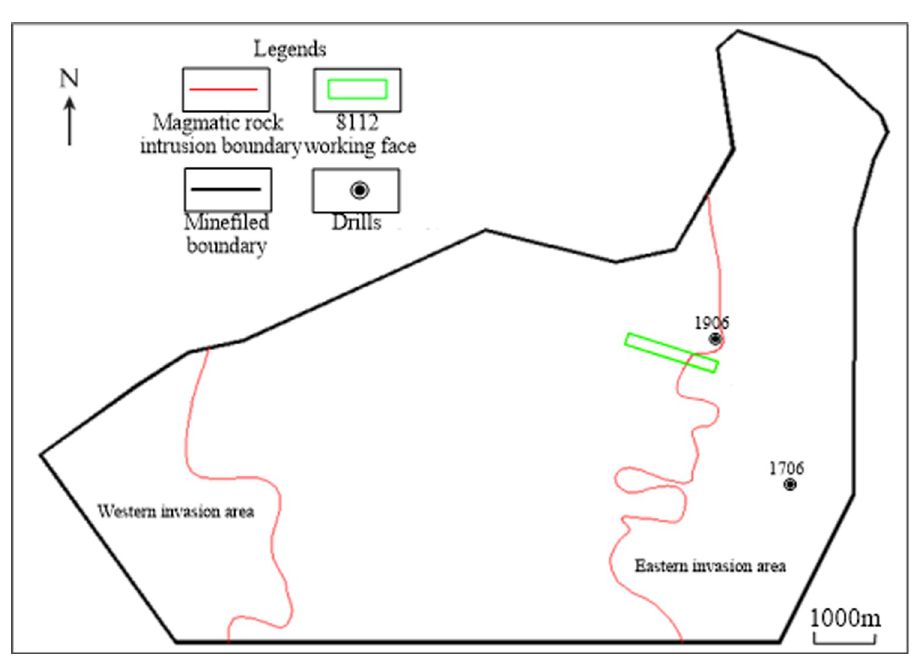
Fig 3. Schematic map of areas of magmatic rocks intruding into the coal seams in the Tongxin Minefield.